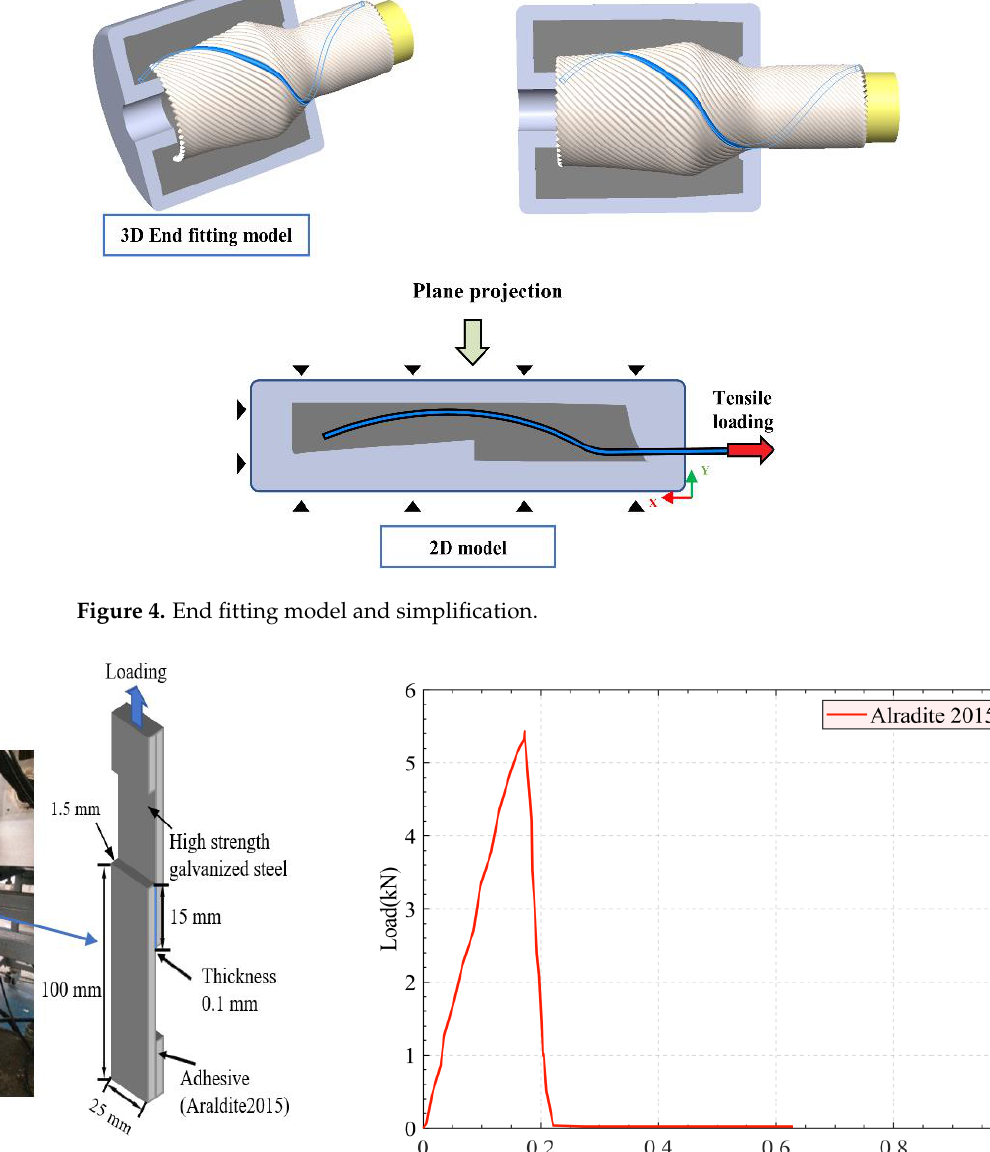
Figure 4. End fitting model and simplification.